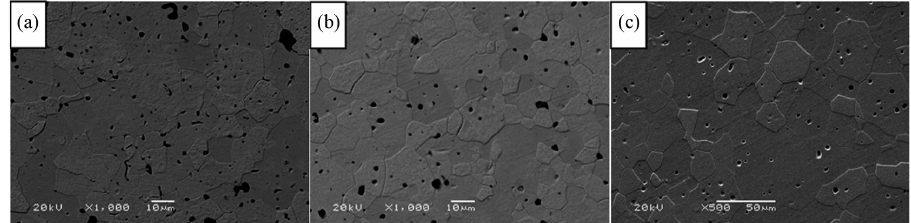
Figure 2: SEM images of molybdenum, Mo-0.5Ti and Mo-0.1Zr: (a) Mo-0.5Ti; (b) Mo-0.1Zr; (c)